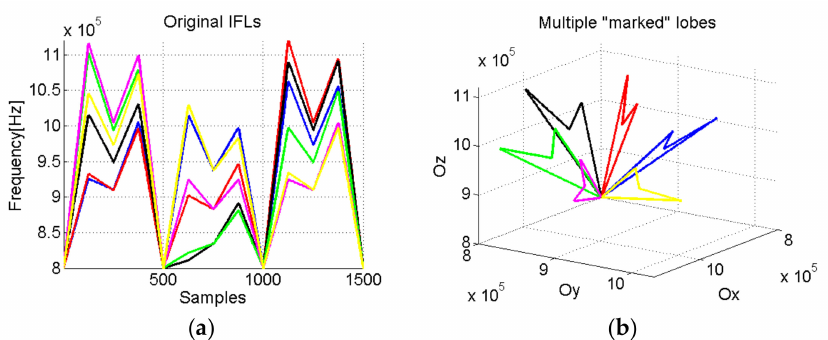
Figure 9. ( a ) IF law auxiliary multiple signals; ( b ) The multiple lobes with signature obtained based on the lobe from Figure 8 and rotated with an angle of π